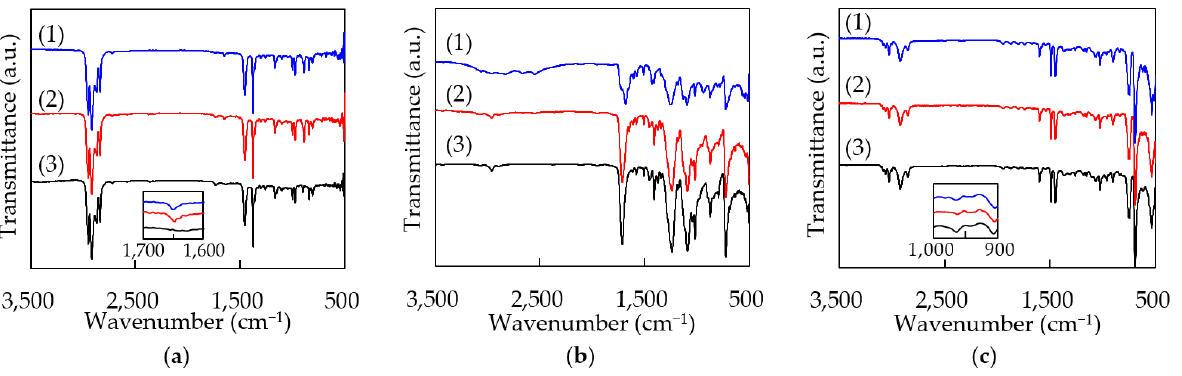
Figure 9. The infrared spectra of the processed surfaces of the films. ( a ) PP, (1) d = 0.6 mm, S = 5 mm/s, (2) d = 0.4 mm, S = 100 mm/s, (3) original, ( b ) PET, (1) d = 0.4 mm, S = 40 mm/s, (2) d = 0.4 mm, S = 100 mm/s, (3) original, ( c ) PS, (1) d = 0.4 mm, S = 75 mm/s, (2) d = 0.4 mm, S = 100 mm/s, (3) original.